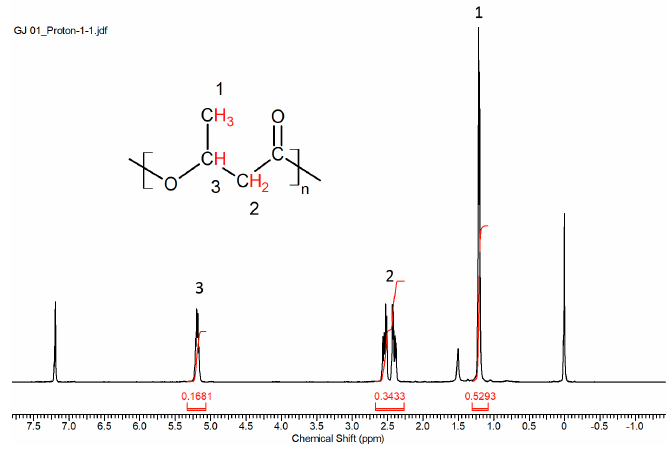
Figure 1. 1 H NMR spectrum of the PHA extracted using chloroform. 1 H NMR (400 MHz, Chloroform- d) δ 5.19 (d, J = 6.7 Hz, 1H), 2.69–2.24 (m, 2H), 1.20 (d, J = 6.2 Hz, 3H). δ 5.19 (d, J = 6.7 Hz, 1H), 2.69–2.24 (m, 2H), 1.20 (d, J = 6.2 Hz,